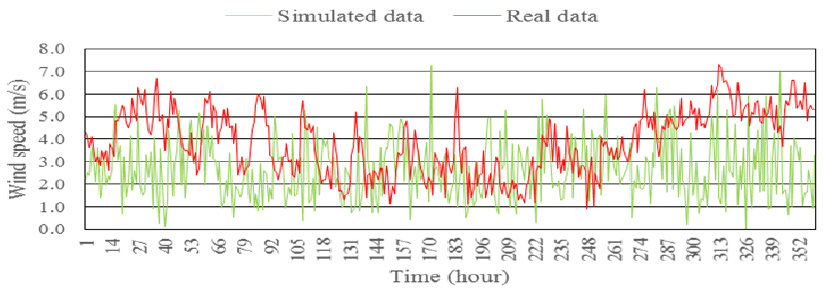
Figure 6. Comparison between real wind speed data and simulated wind speed data from the Weibull model for two weeks at Mersing in 2015.